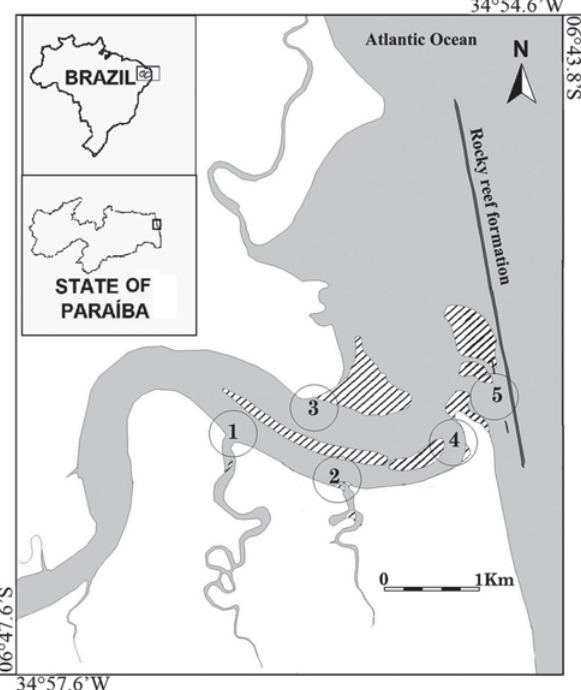
Fig. 1. Mamanguape estuary, State of Paraíba, NE Brazil, showing surveyed sub-areas: 1) Tanques; 2) Peixe-Boi; 3) Cação; 4) Transition; and 5) Reefs. Dashed areas represent